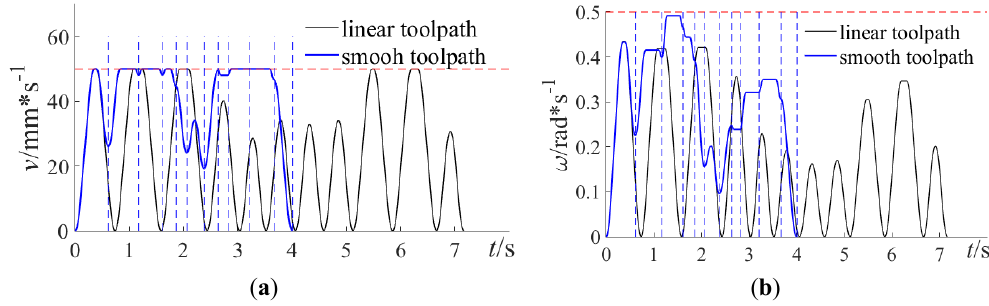
Figure 12. Feedrate profile with respect to time—( a ) Tool-tip position. ( b ) Tool